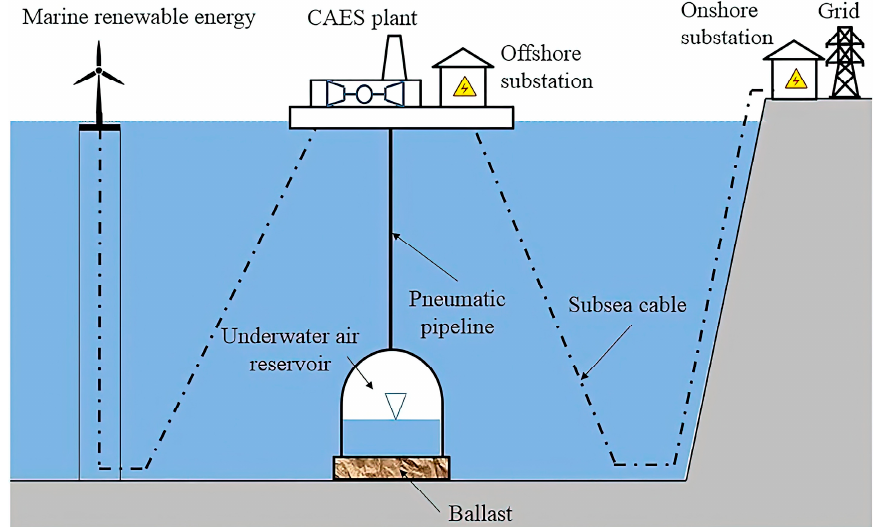
Figure 9. Schematic diagram of an offshore wind farm with offshore compressed air energy storage connected to the grid. CAES stands for compressed air energy storage [53].